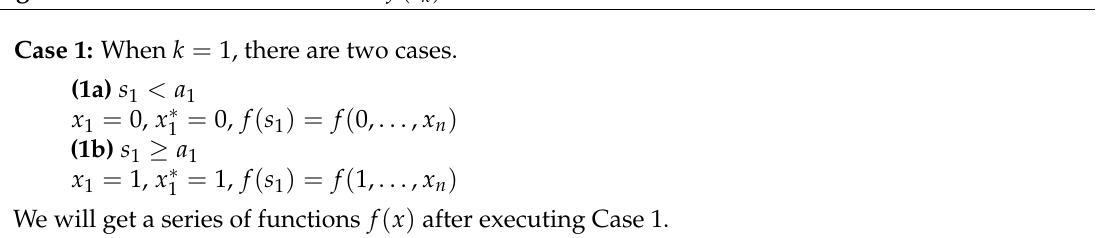
Algorithm 2 Calculation Method of f ( s k